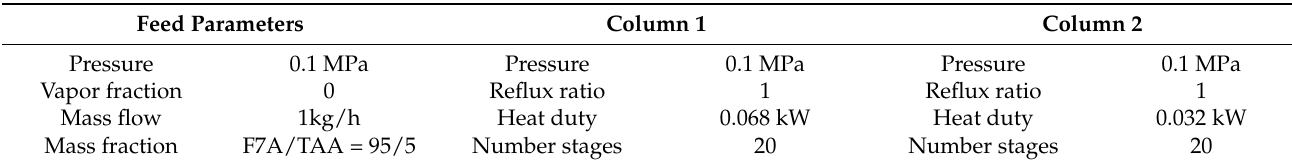
Table 2. Key parameters and heat duty in column 1 and column 2.